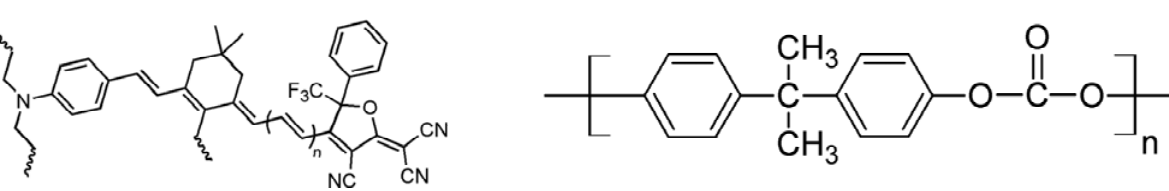
Figure 9. Molecular structures of AJLZ53 chromophore ( left ) and polycarbonate ( right